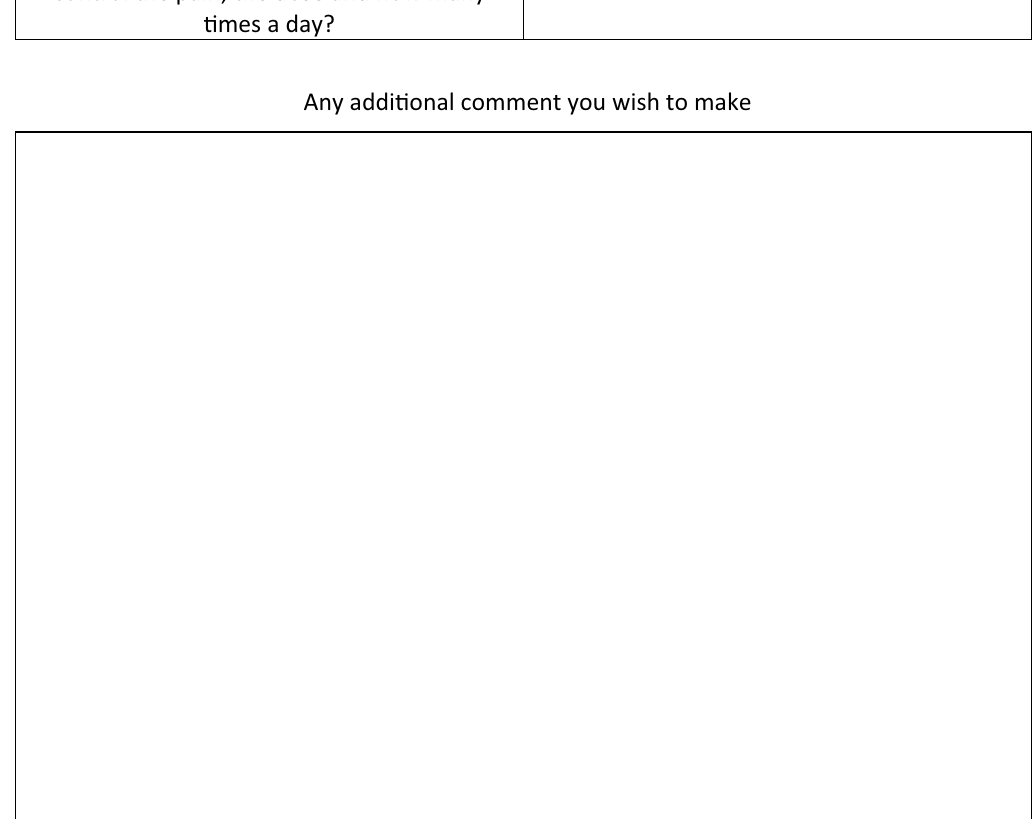
Table 1. Postoperative quality of life scale form. A lower score indicates a better quality of life.